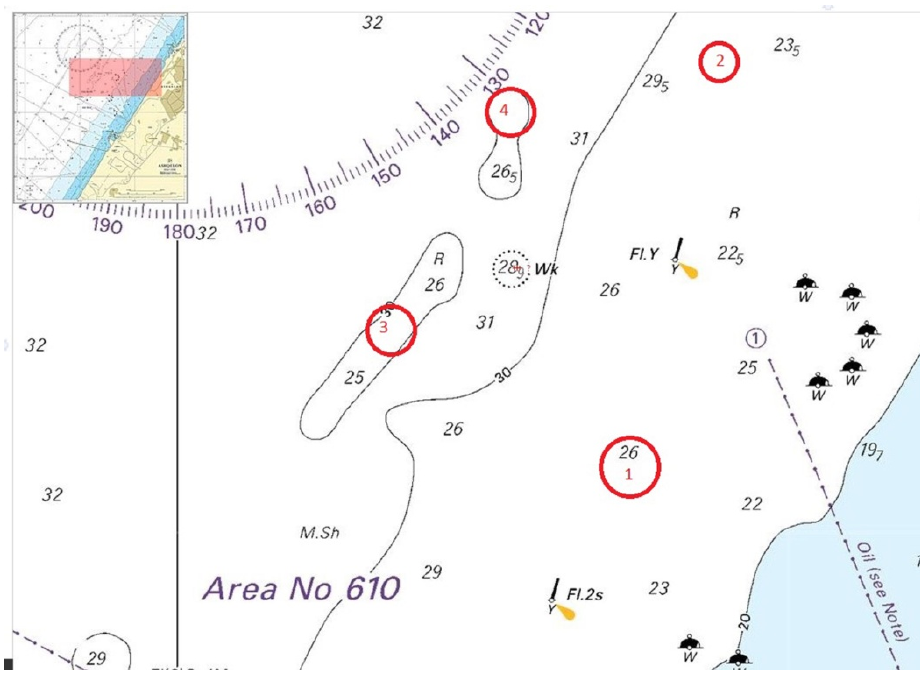
Figure 1. Data collection sites: (1,2)—Sand sites at 26 m. (3,4)—Sandstone sites at 33 m .